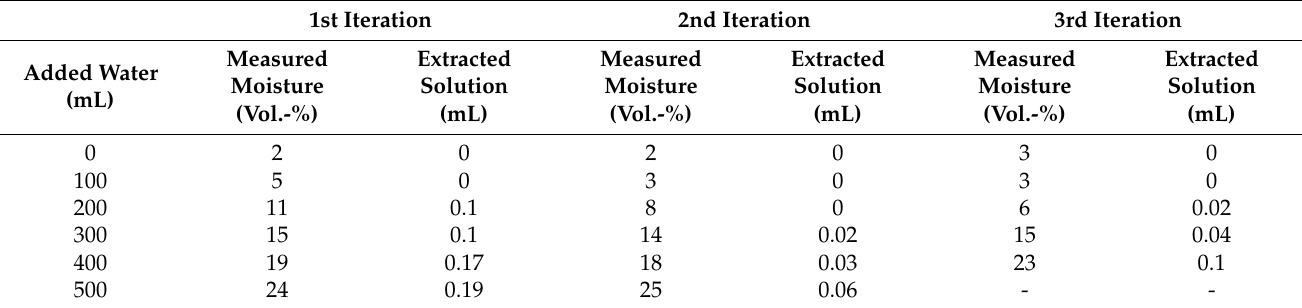
Table 2. Experimental series of repeated water extraction from garden soil for different soil moisture levels. The moisture level was increased by adding water in steps. The volume of extracted solution for a 30 min pump period was measured. 1st Iteration 2nd Iteration 3rd Iteration Added